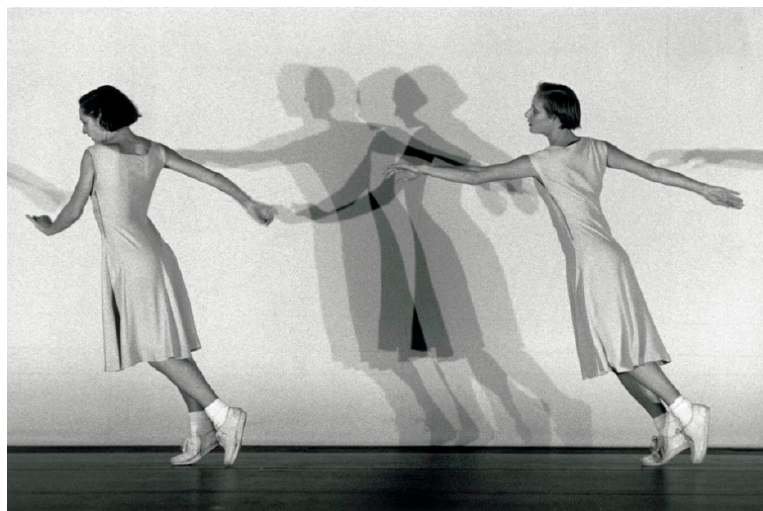
Figure 10. Fase (1982) Anne Teresa De Keersmaeker / Rosas © Herman Sorgeloos. Used with permission.